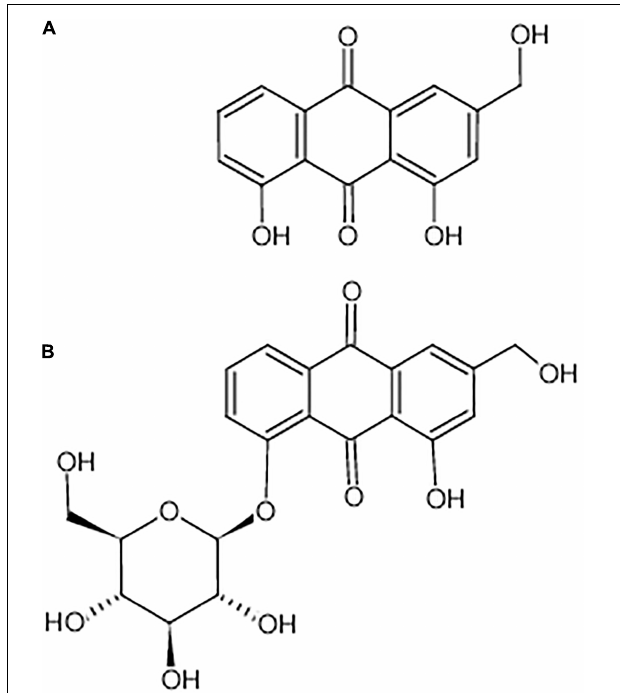
FIGURE 1 | Chemical structure of aloe-emodin. Aloe-emodin is an anthraquinone derivative and is either presented in aloe in free form (A) or presented in rhubarb, senna, and aloe in the form of glycosides (B) .